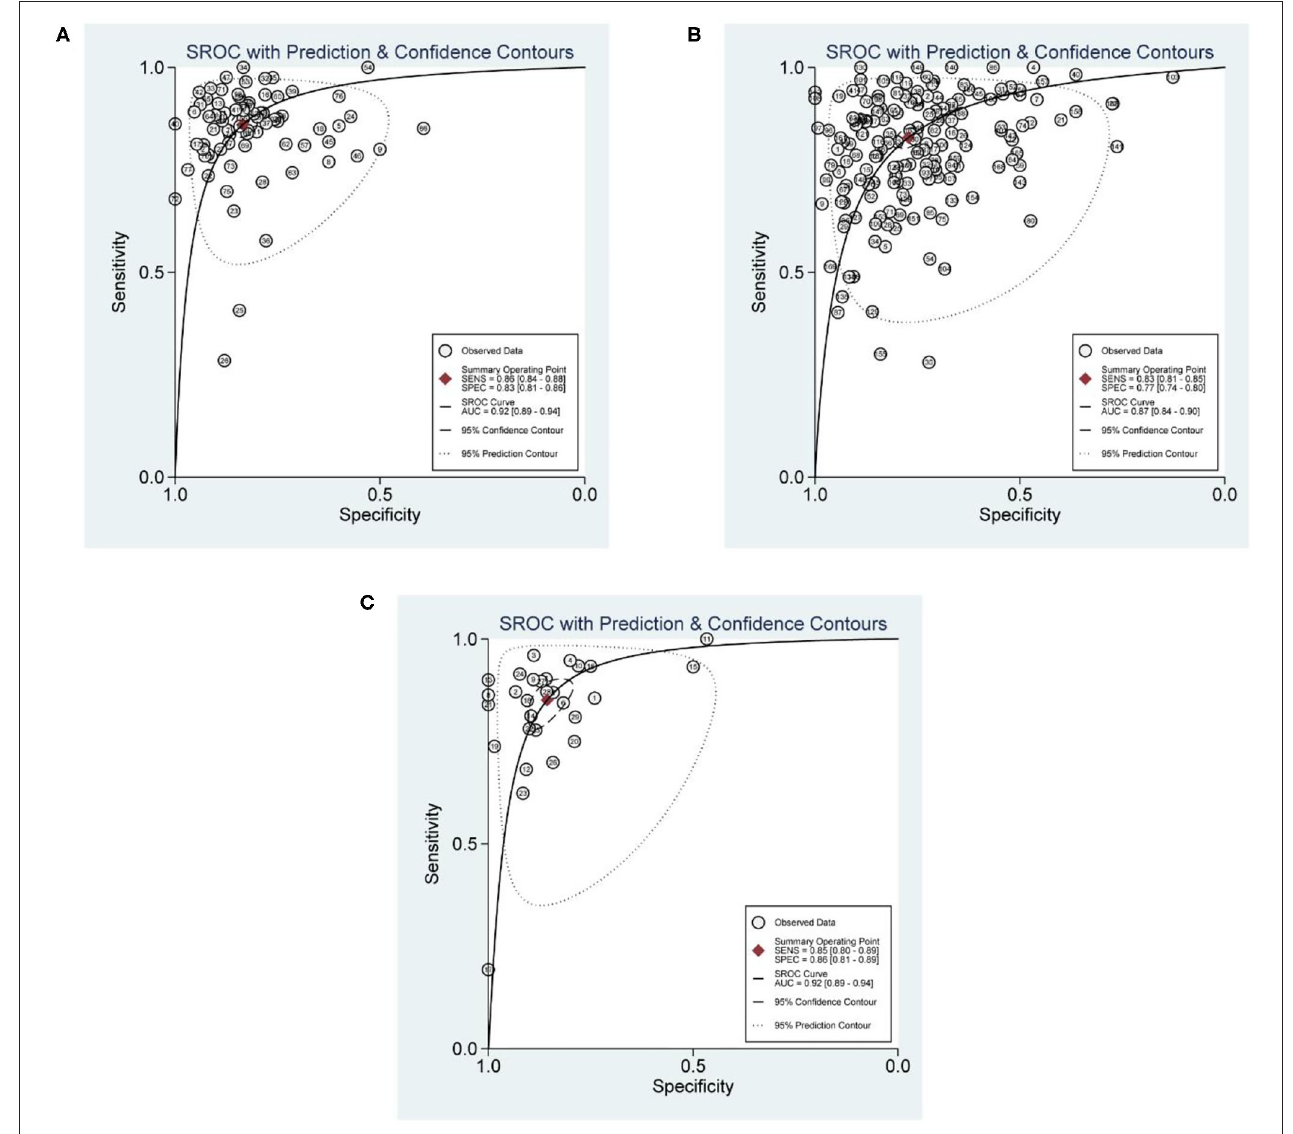
FIGURE 3 | SROC curves for diagnostic performance of CMR, SPECT, and PET. (A) SROC curve for diagnostic performance of CMR. (B) SROC curves for diagnostic performance of SPECT. (C) SROC curves for diagnostic performance of PET.